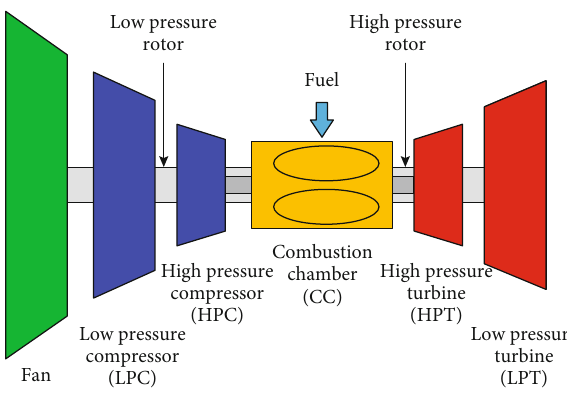
Figure 1: The structural diagram of the typical two-spool